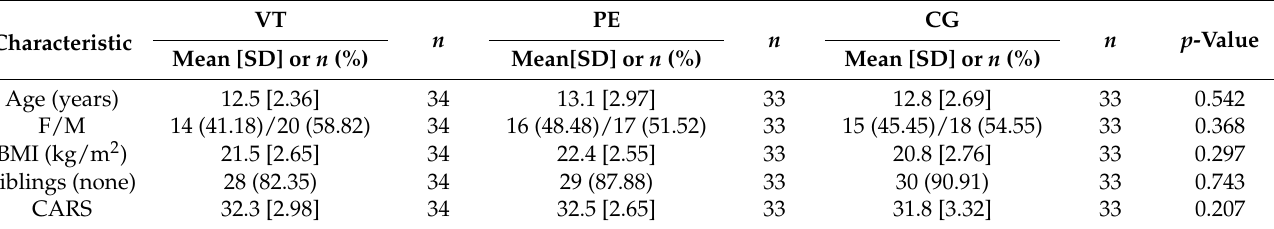
Table 1. Demographics of the three groups of children with ASD enrolled in this